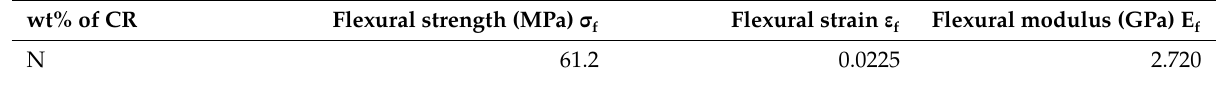
Table 13: Flexural properties for various composition of CFR based composite. wt% of